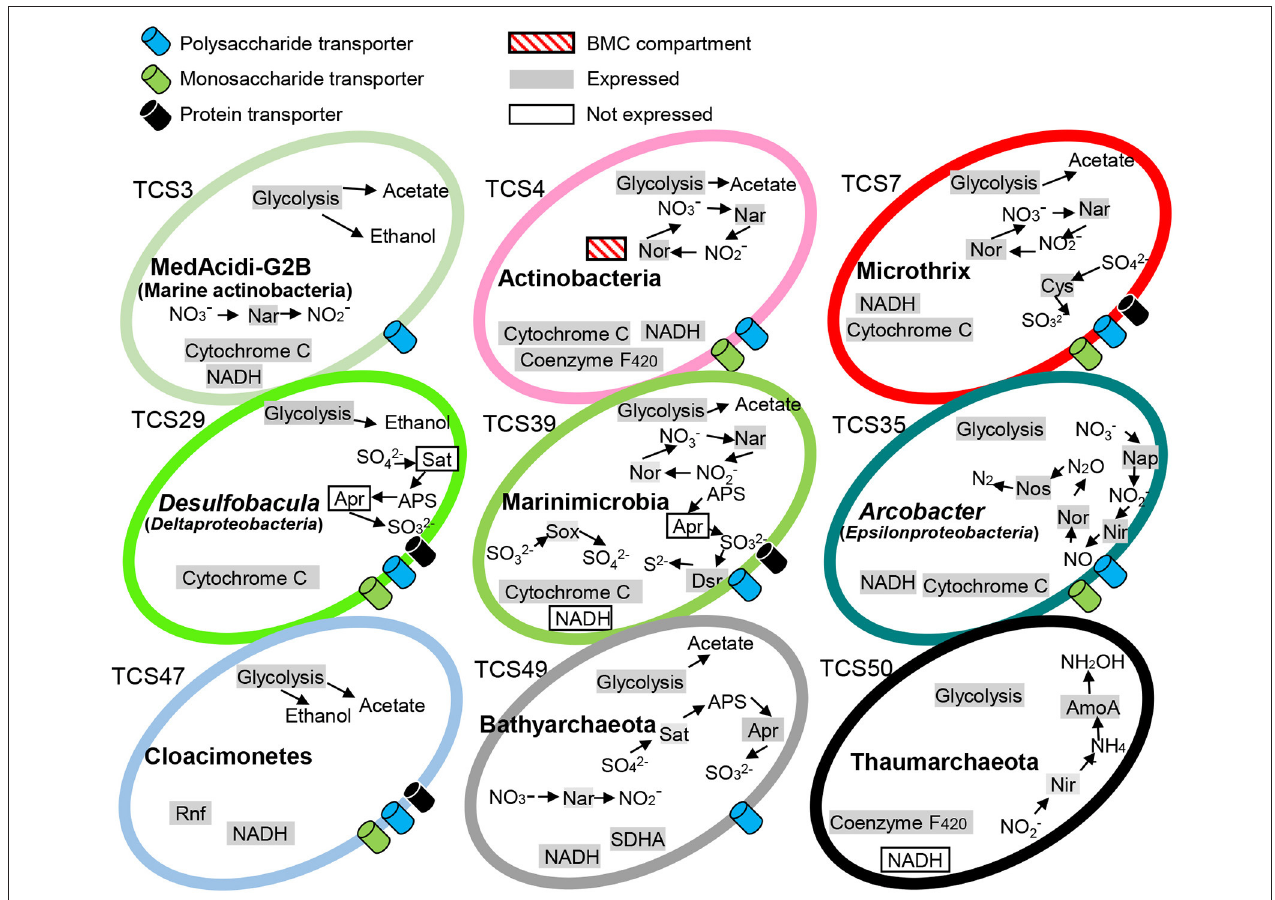
FIGURE 1 | Metabolic capacities of representative microorganisms based on genomic and metatranscriptomic analyses. The complete pathways responsible for carbohydrate fermentative metabolism as well as energy generation were detected in the MAGs. The expression profiles of these pathways were examined by mapping transcripts to key functional genes. TCS, Thuwal cold seep; Rnf, Rhodobacter nitrogen fixation; BMC, putative bacterial microcompartment; SDHA, succinate dehydrogenase complex subunit A. The 51 MAGs were numbered